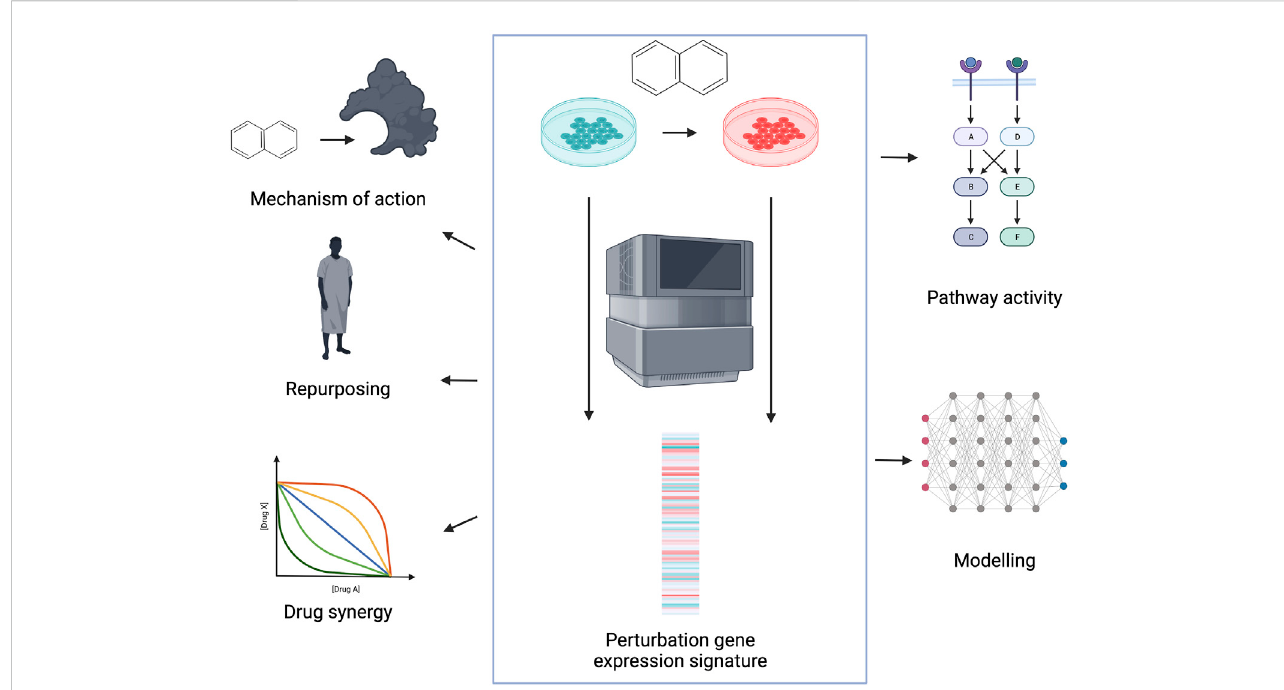
FIGURE 1 Applicationofperturbationgeneexpressionpro fi lesindrugdiscovery.Perturbationgeneexpressionsignaturesarede fi nedasdifferentialexpression(DE) signaturesbetweenperturbedandcontrolsamples(middle).Signaturescanbeusedtoidentifycompoundmechanismsofaction,torepurposeexistingdrugs for new indications, to identify synergistic combinations and for mechanistic understanding and following modelling of the drug induced perturbation phenotypes. Created with